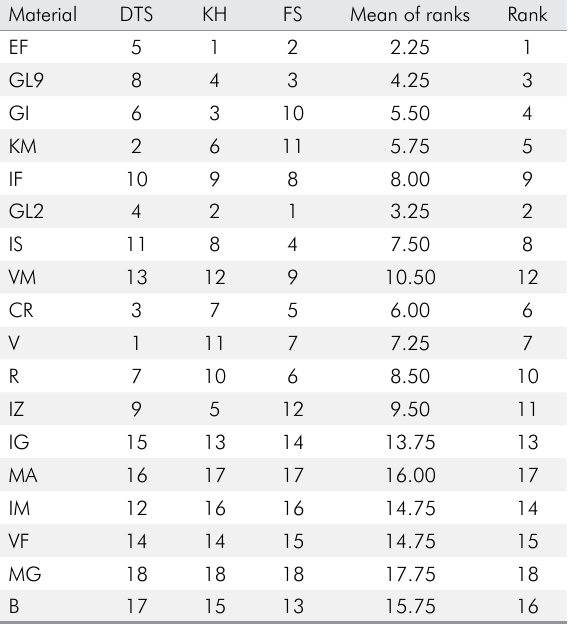
Table 3. Rank orders of mechanical test results (based on CS).